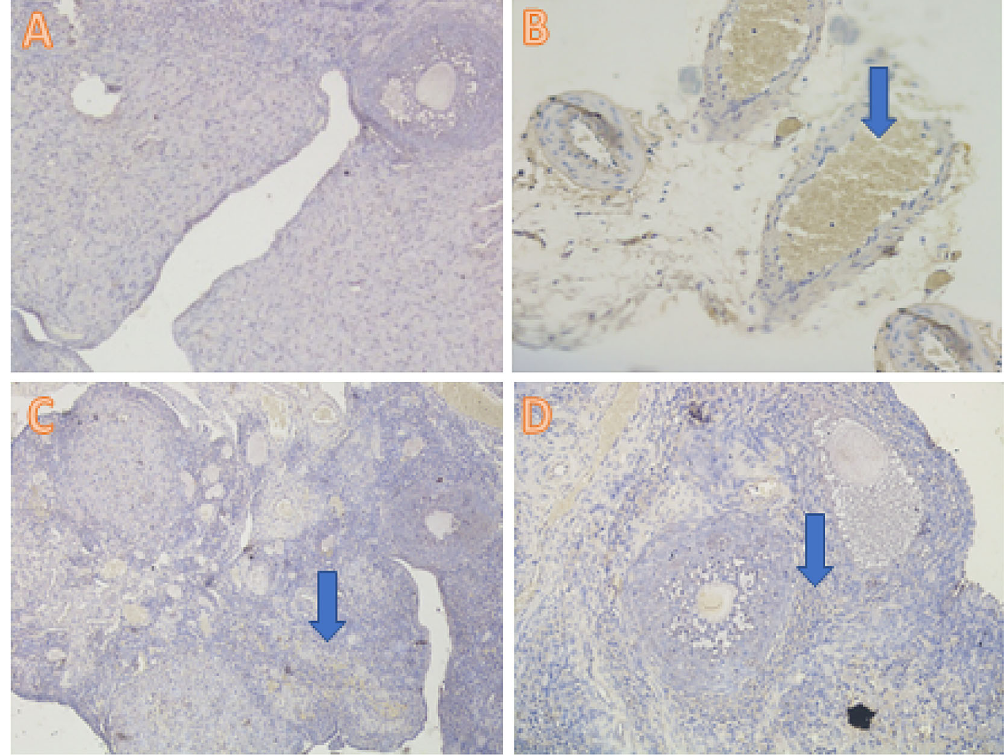
Figure 2. Average score of TNF- α expression (brown): (A) fertile female, negative control group (T (cid:1) ) = 0.30 a (cid:4) 0.48; (B) infertile female, positive control group (T+) = 9.50 c (cid:4) 1.78; (C) infertile female with 30% honey v/v group (T1) = 4.40 b (cid:4) 3.02; (D) infertile female with50% honey v/v group (T2) = 2.50 ab (cid:4) 1.65. (A – D) 400 (cid:3) with the IHC method. IHC =